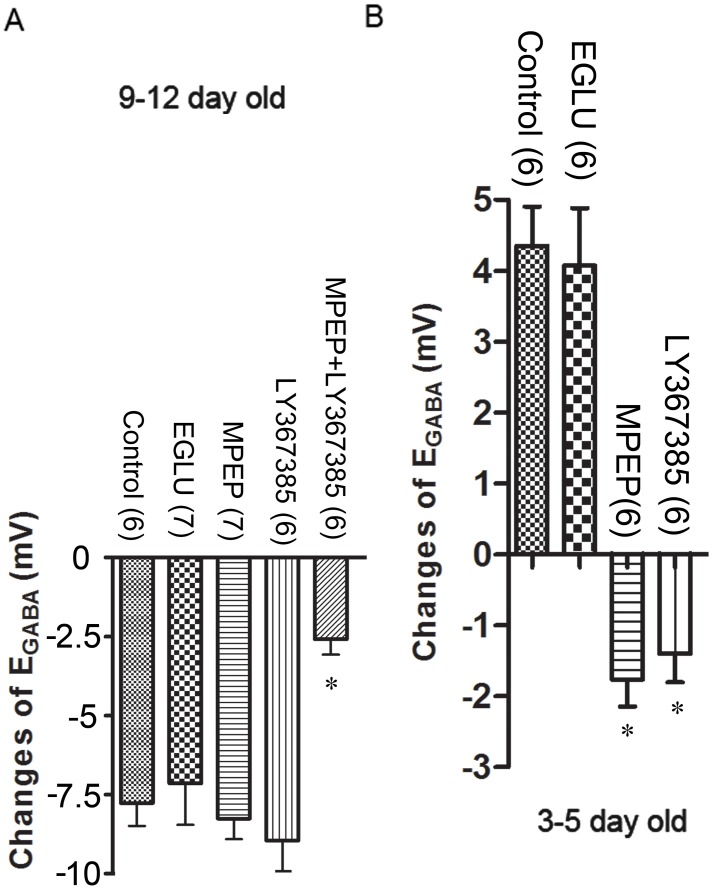
Different effects of mGluR antagonists on TBS-induced shifts in EGABA in juvenile and neonatal rat hippocampal neurons.In panel A, MPEP and LY367385 did not block TBS-induced negative shifts in EGABA as observed in control condition (reported in [2,3] in 9–12 day old rat hippocampal neurons while the co-application of these two antagonists blocked this negative shift in EGABA. In panel B, either MPEP or LY367385 is able to inhibit TBS-induced positive shifts in EGABA in 3–5 day old rat hippocampal neurons. EGLU didn’t block the TBS-induced shifts in both 9–12 and 3–5 day old rat hippocampal neurons. The n in brackets refers to the number of neurons. *P<0.05.